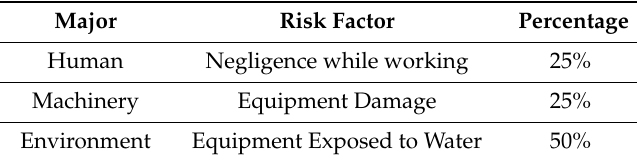
Table 8. Common causes of non-loading and unloading